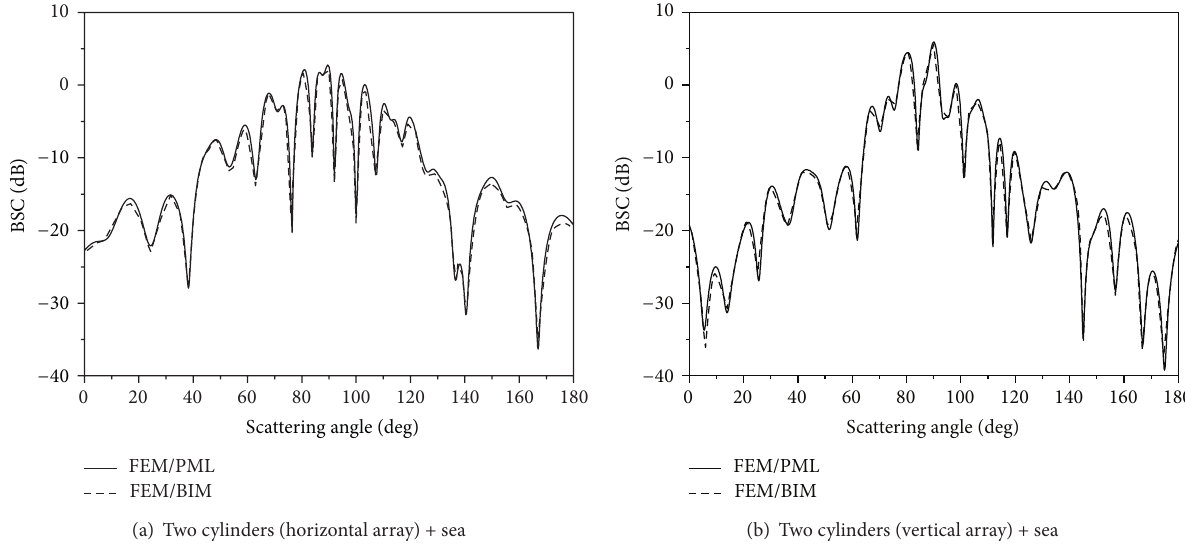
Figure 3: BSC from two cylinders over the PM rough sea